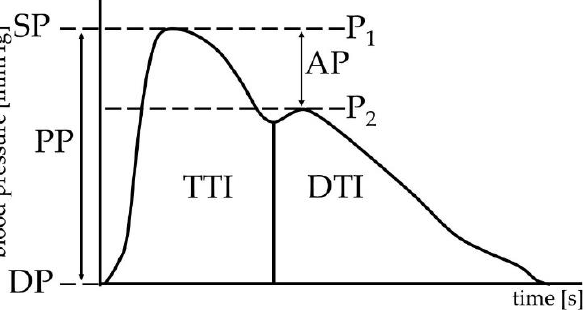
Figure 1. Central pulse curve. SP—systolic blood pressure, DP—diastolic blood pressure, PP—pulse pressure, P 1 —pressure at the peak systolic (forward) pulse wave, P 2 —pressure at the peak of re- flected (backward) pulse wave, AP—augmentation pressure, TTI—tension time index, DTI—diastolic time index.